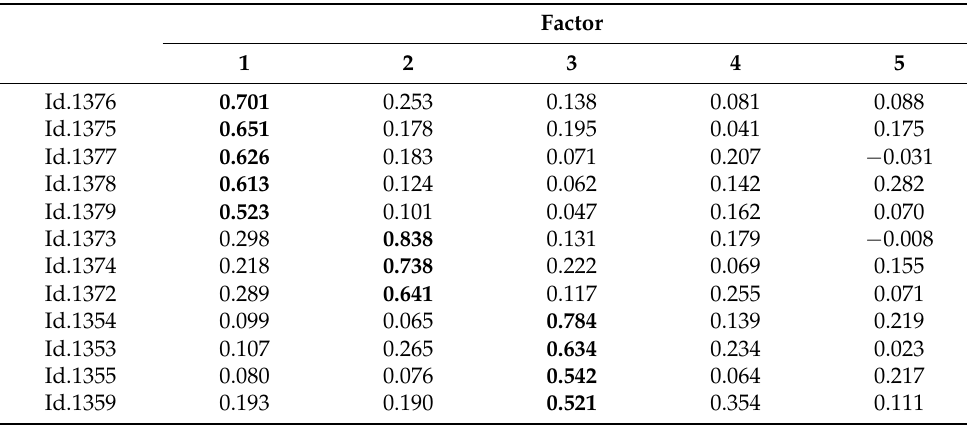
Table 3. Exploratory factor analysis (n = 444)—items related to the psychological domain.